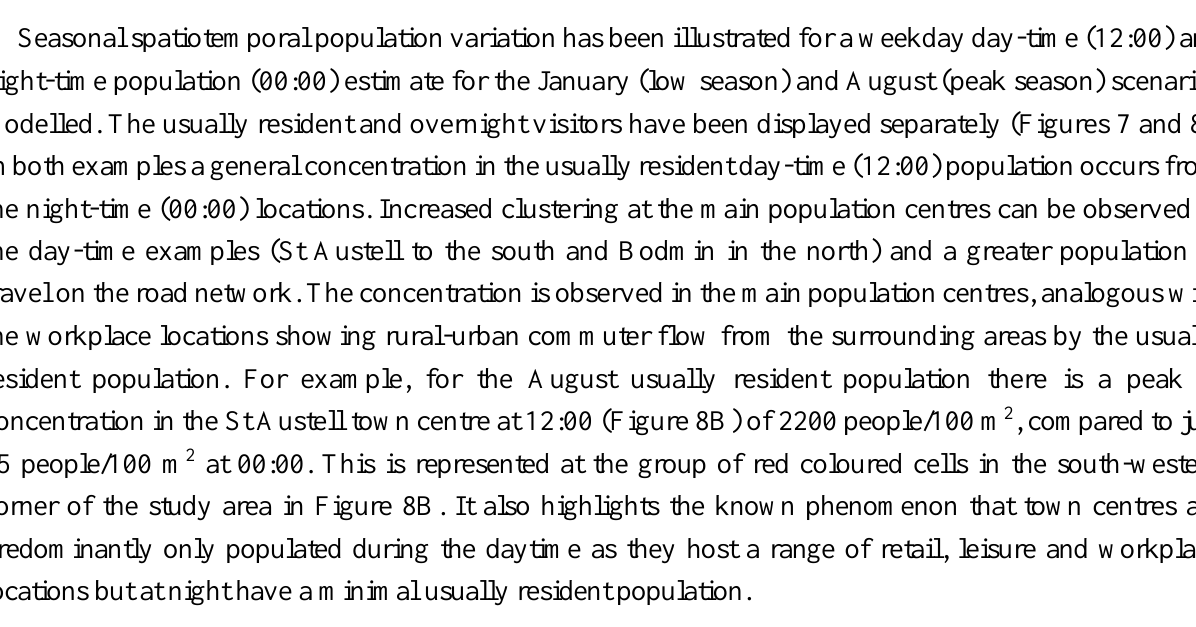
Figure 6. Flood exposure estimates from the Environment Agency Flood Map Zone 3 for the St Austell study area using census and seasonal spatiotemporal model outputs at hourly intervals for a “typical”